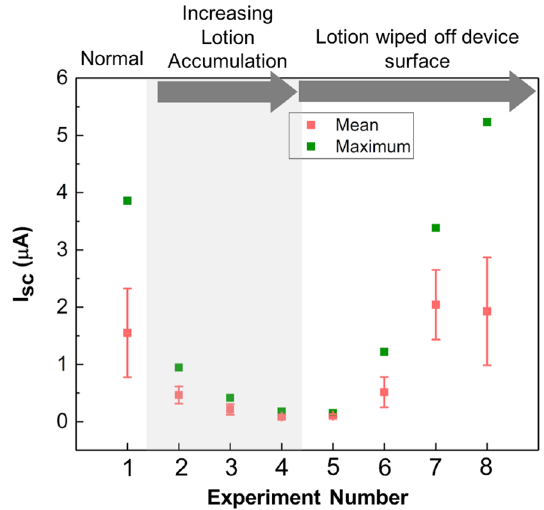
Figure 5. Maximum and mean values of current output generated upon repeated touch actions on a lotion-contaminated sensor surface. The experiment numbers are explained in the text.